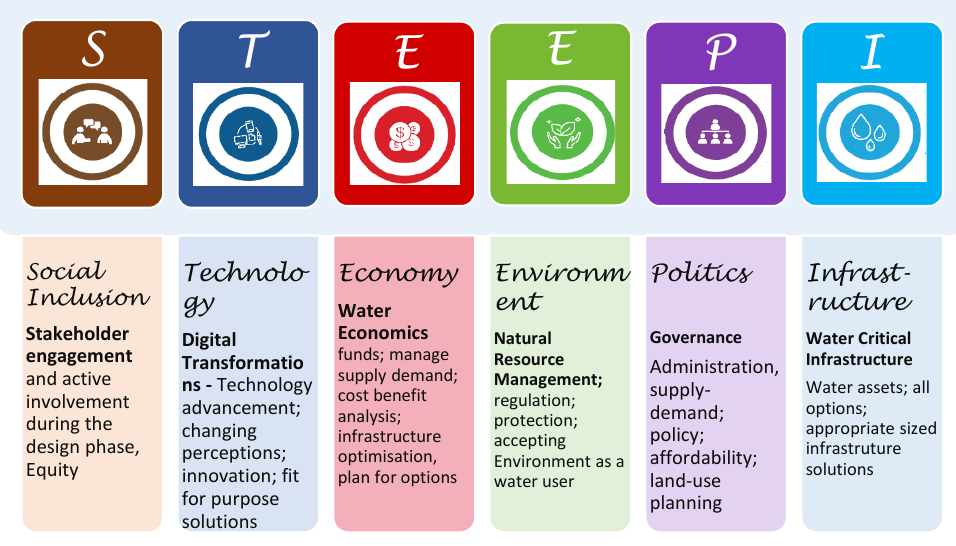
Figure 1. Adapted STEEPI framework definition.